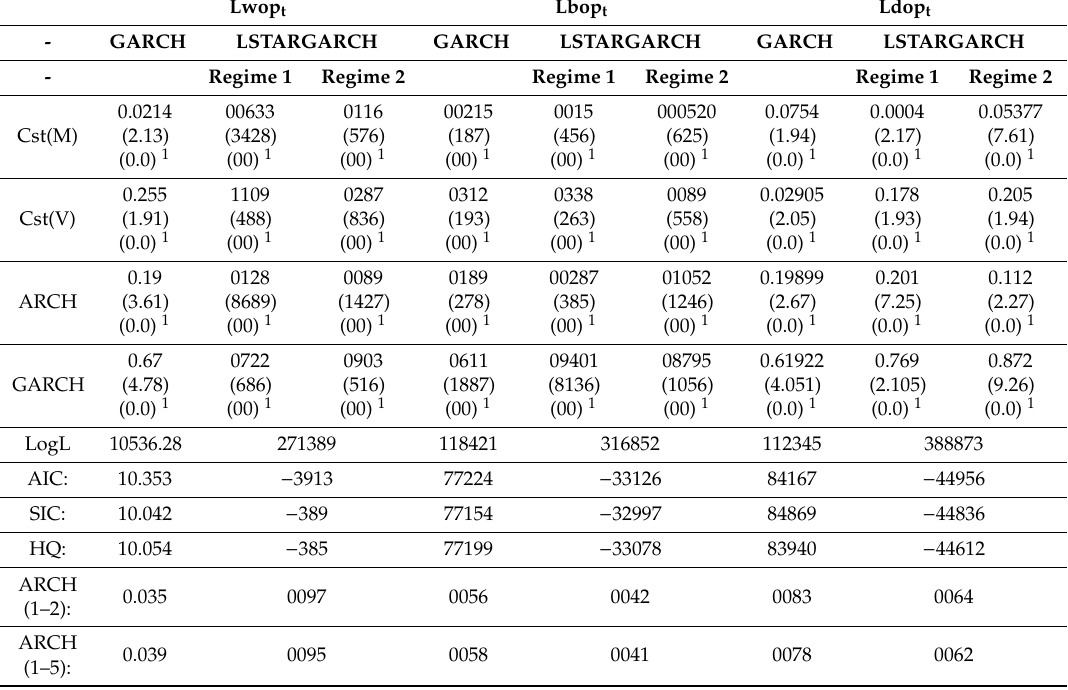
Table 5. Baseline models. LogL: Log-likelihood, ARCH(p): pth order ARCH–LM test, AIC: Akaike information criterion, SIC: Schwarz information criterion, HQ: Hannan–Quinn information